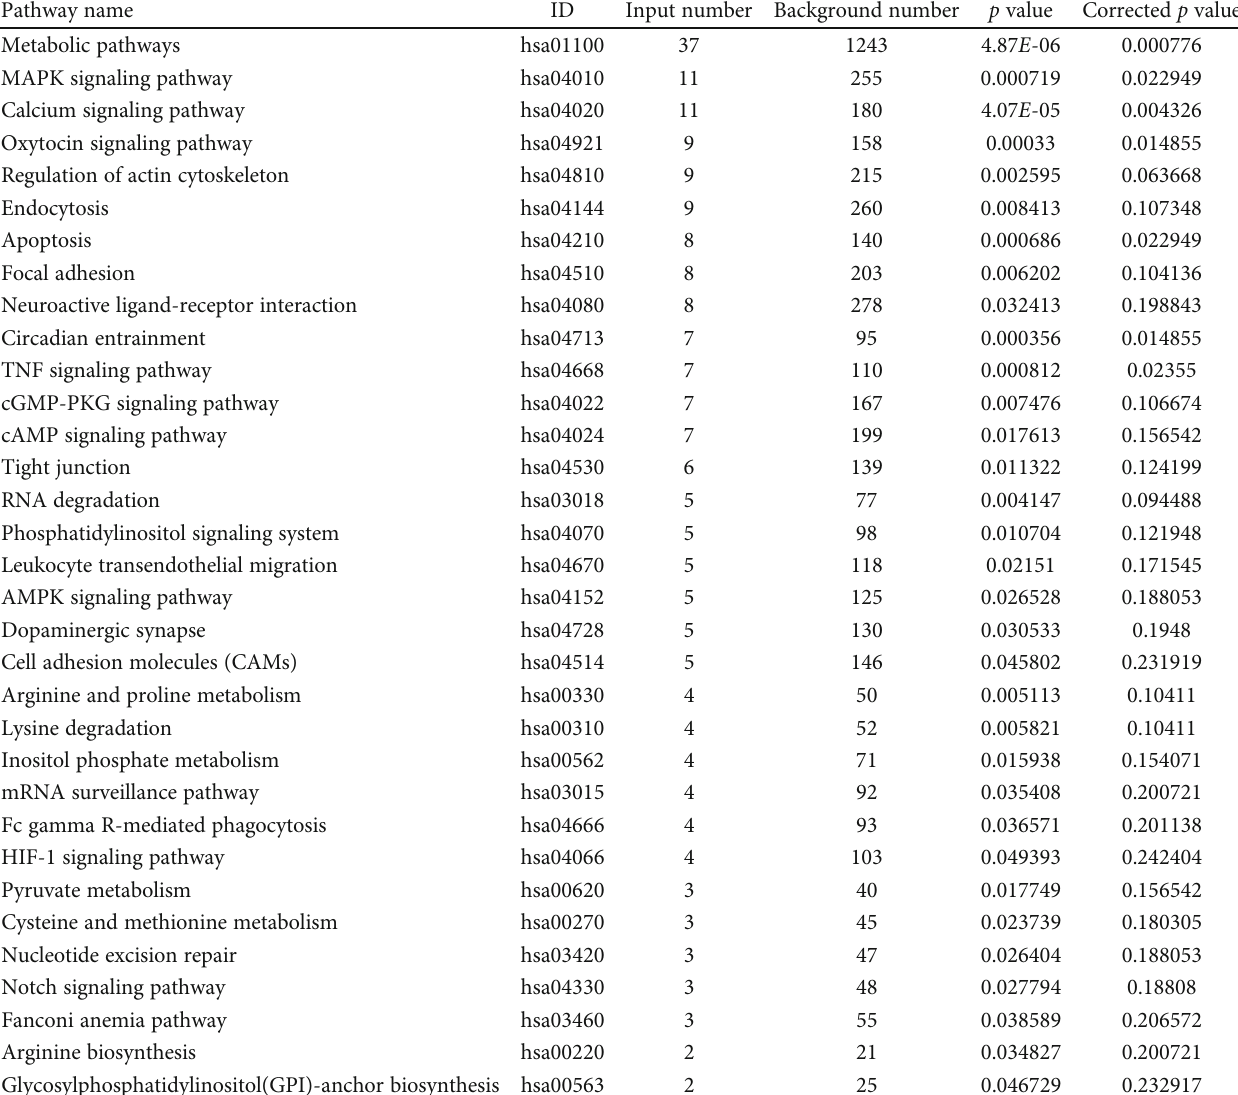
Table 4: KOBAS pathway enrichment results of 583 di ff erentially expressed